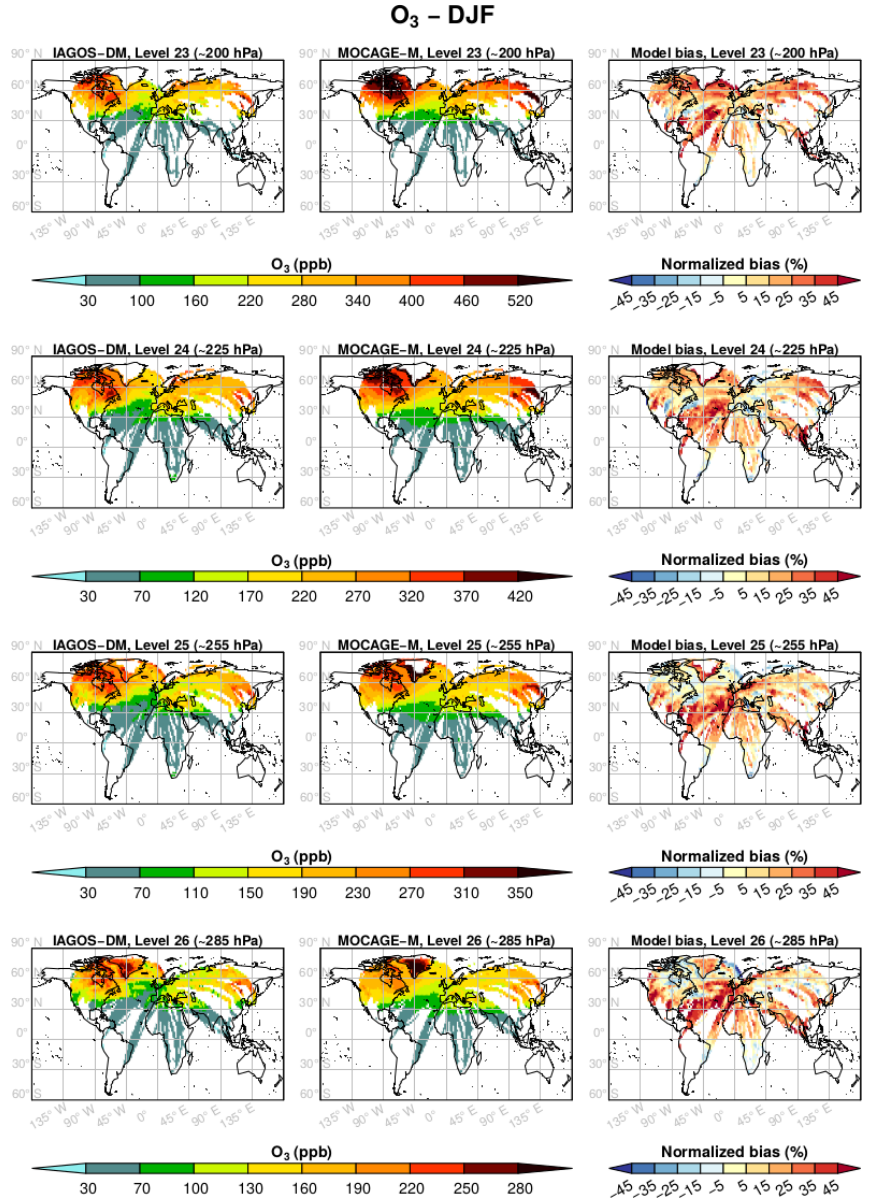
Figure A1. As Fig. 3 for boreal